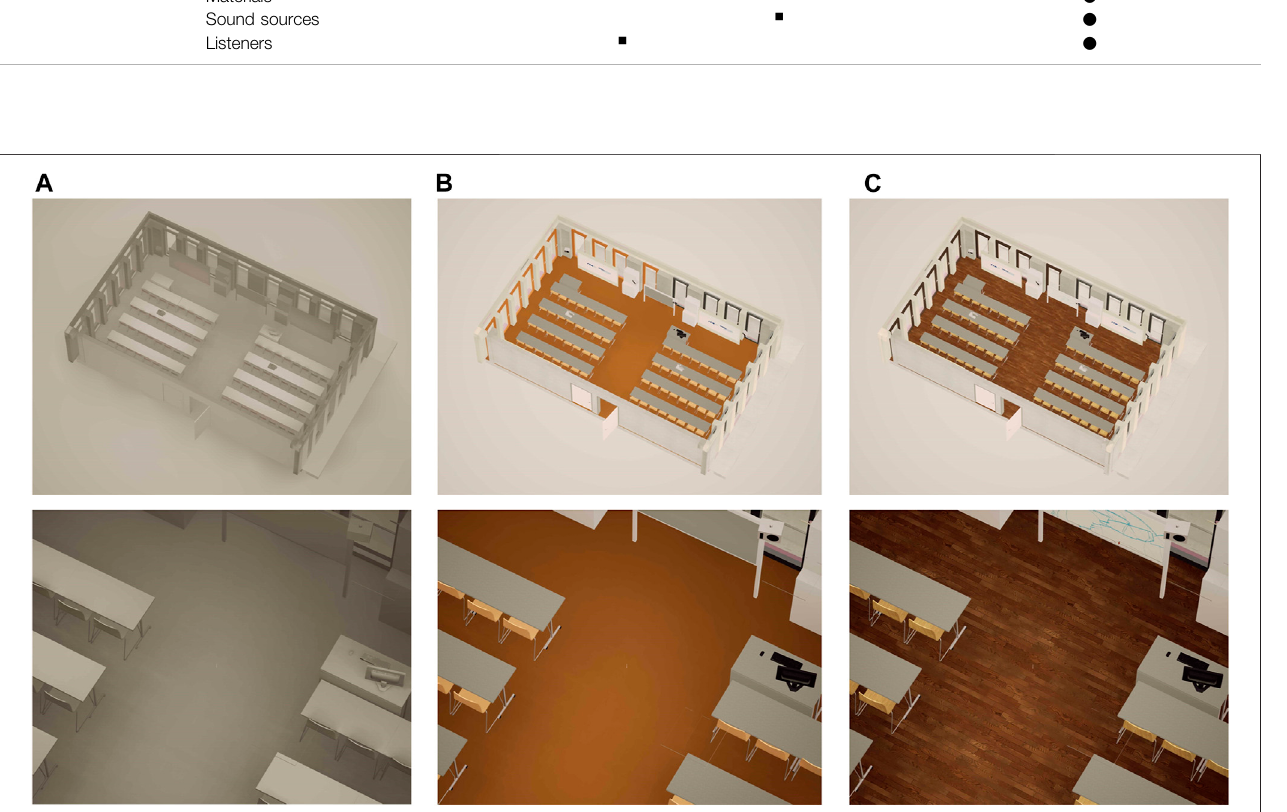
FIGURE 1 | Levels of detail for the material de fi nitions of the visual cues: (A) monochrome materials, white; (B) color materials; (C) pbr